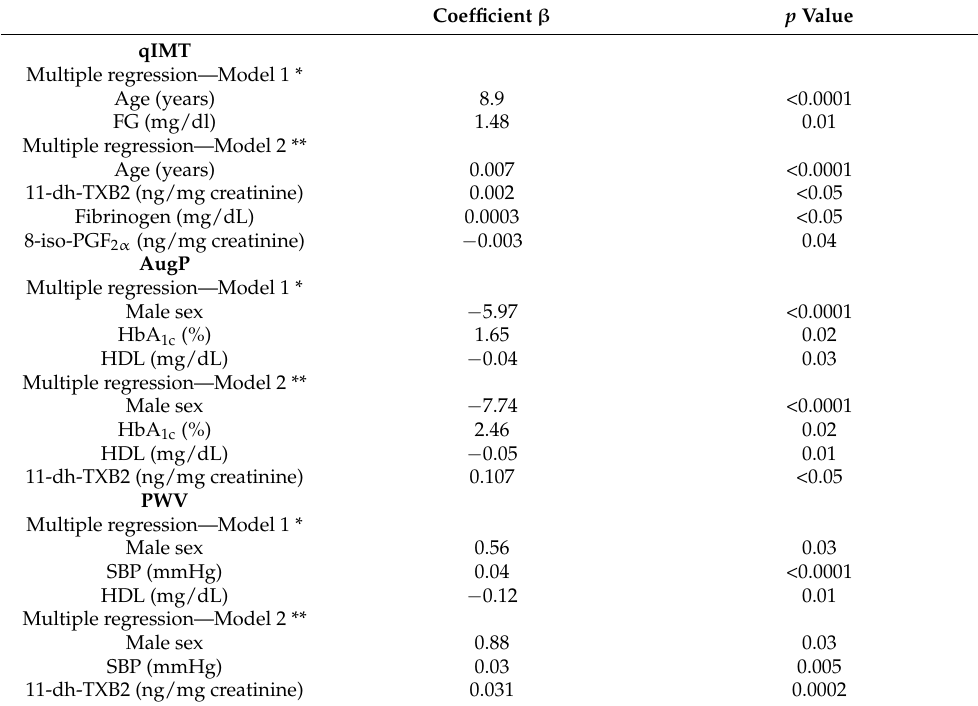
Table 4. Multiple regression analysis evaluating qIMT, AugP and PWV as dependent